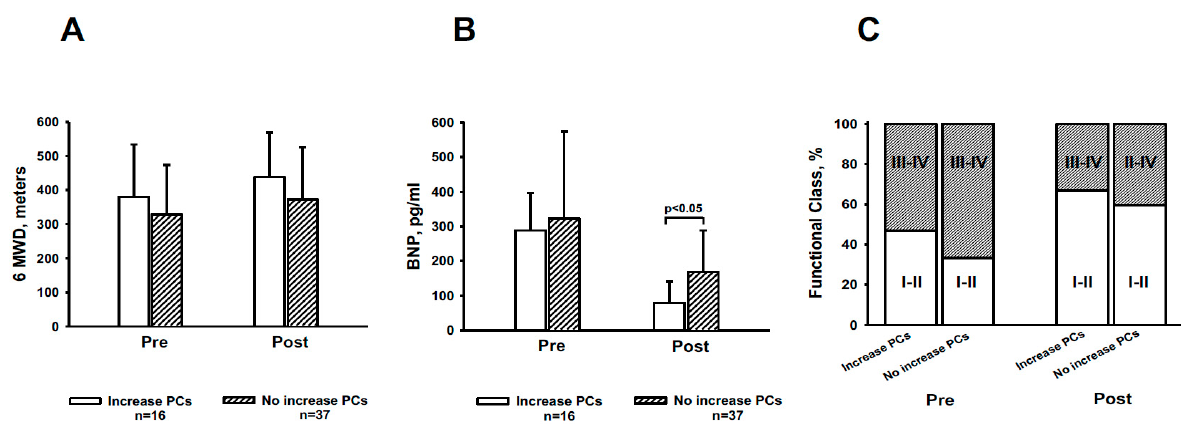
Figure 4. Clinical effects of treatment according to the change induced in circulating progenitor cells. Values of six-minute walking distance (6MWD) ( A ), brain natriuretic peptide (BNP) ( B ) and functional class ( C ) in 53 patients with pulmonary arterial hypertension (PAH), before (Pre) and 3 months after (Post) initiating targeted PAH therapy. Patients were stratified according to the change in CD34 + CD133 + CD45 low labelled cells (PCs) after treatment. Open bars show values of patients who showed an increase in circulating PCs, n = 16 dashed bars show values of patients showing a decrease or no change in circulating PCs, n = 37.